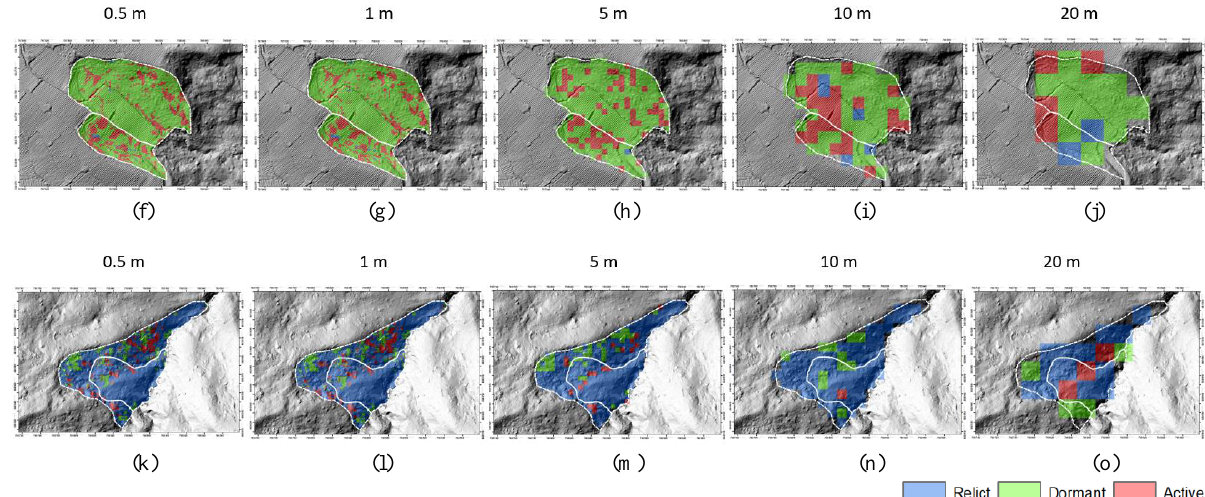
Figure 6 . Sample of classified landslide activity for shallow translational landslide with different spatial resolution using SVM RBF- GS method where, (a) – (e) for active, (f) – (j) for dormant, and (k) – (o) for relict